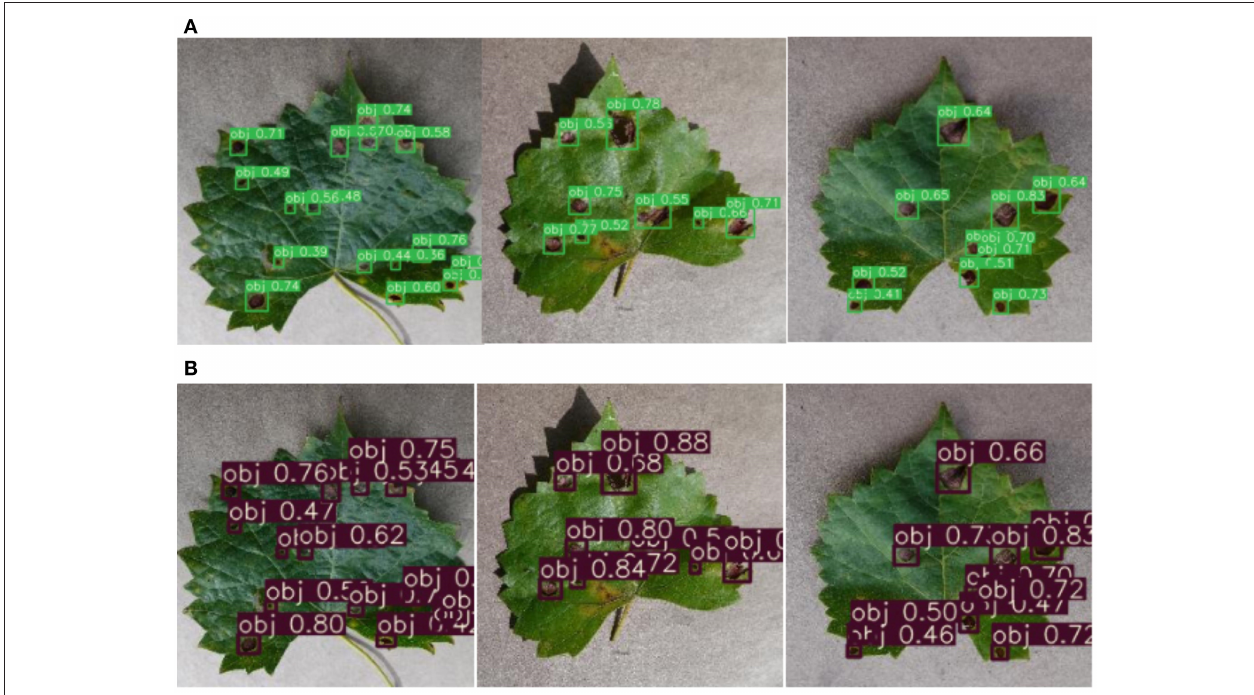
FIGURE 11 | The detection results before and after the data is enhanced for test_pv. (A) The detection results of YOLOv3-SPP trained on the unenhanced images. (B) The detection results of YOLOv3-SPP trained on the enhanced images.